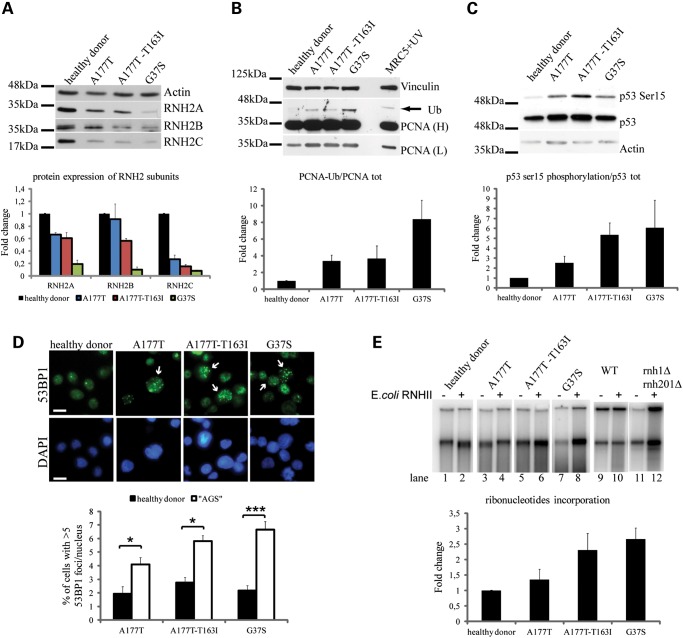
Patients-derived AGS cells accumulate genomic rNMPs and replication stress markers. Protein levels of the three subunits of RNase H2 complex from cells derived from healthy donor and AGS patients are compared by western blot (top panel) and quantified (bottom panel). Error bars represent mean ± s.e.m., n = 3 (A). Immunoblot against PCNA on total protein extract from healthy donor and AGS-derived lymphoblastoid cells, MRC5VI cells UV irradiated (20 J/m2) were used as positive control for PCNA ubiquitylation (L, low exposure; H, high exposure) and Vinculin as loading control (top panel). The ratio of monoubiquitinated PCNA to total PCNA is plotted (bottom panel). Error bars represent mean ± s.e.m., n = 5 for healthy donor, A177T, A177T-T163I; n = 2 for G37S (B). DDR in control and AGS-mutated cells was monitored by western blot analysis using anti-P-Ser-15-p53 antibody and Actin as loading control (top panel). The ratio between P-Ser-15-p53 and total p53 was quantified (bottom panel). Error bars represent mean ± s.e.m., n = 3 (C). Representative images of immunostaining anti-53BP1 and nuclei (scale bar: 10 μm, magnification ×63) (top panel). Quantification of 53BP1 foci formation in lymphoblastoid cells from healthy donor and AGS patients. Error bars represent mean ± s.e.m., n = 5 for A177T and A177T-T163I, n = 8 for G37S (bottom panel). *P < 0.02; ***P < 0.0001(t-test) (D). DNA extracted from control and AGS-mutated cells was digested (even lanes) with bacterial RNase HII before nick translation reaction in the presence of 32P-dCTP. Labeled DNA was run on a 1% agarose gel and visualized by autoradiography. Control samples were not digested with RNase HII (odd lanes) to detect background signal; wild-type or RNase H1 and H2 deleted (rnh1Δrnh201Δ) budding yeast strains were used to validate the protocol (lanes 9–12) (top panel). Graph represents quantification of three independent experiments, as described in Materials and Methods (bottom panel). Error bars represent mean ± s.e.m., n = 3 (E).